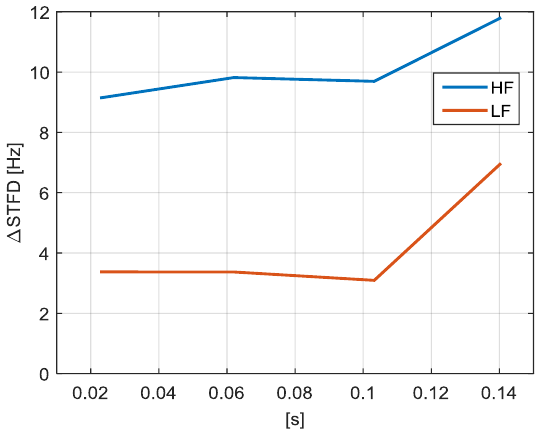
Figure 35. Case study 2: Δ STFD at low-frequency (0 ÷ 2 kHz, red line) and at high-frequency (2 ÷ 150 kHz, blue line) obtained through Prony’s method. Energies 2017 , 10 , 1633